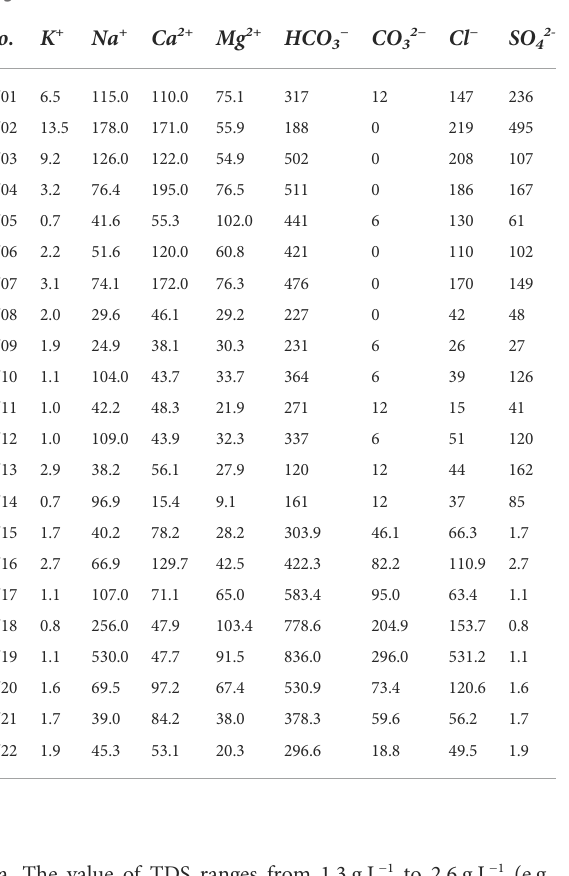
TABLE 6 Ion concentration of water samples in the YRD pro fi le (mg L − 1 ). No. K + SO 4 2-